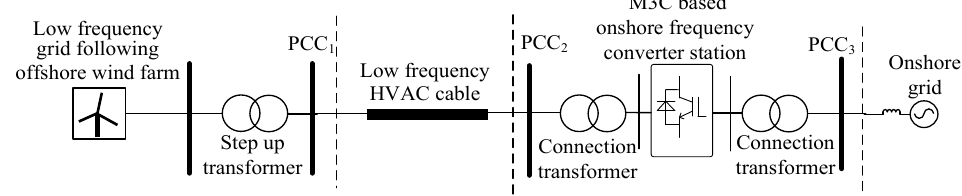
Figure 2. Scheme 2: Low-frequency AC transmission scheme for low-frequency grid-following off- shore wind farms. offshore wind